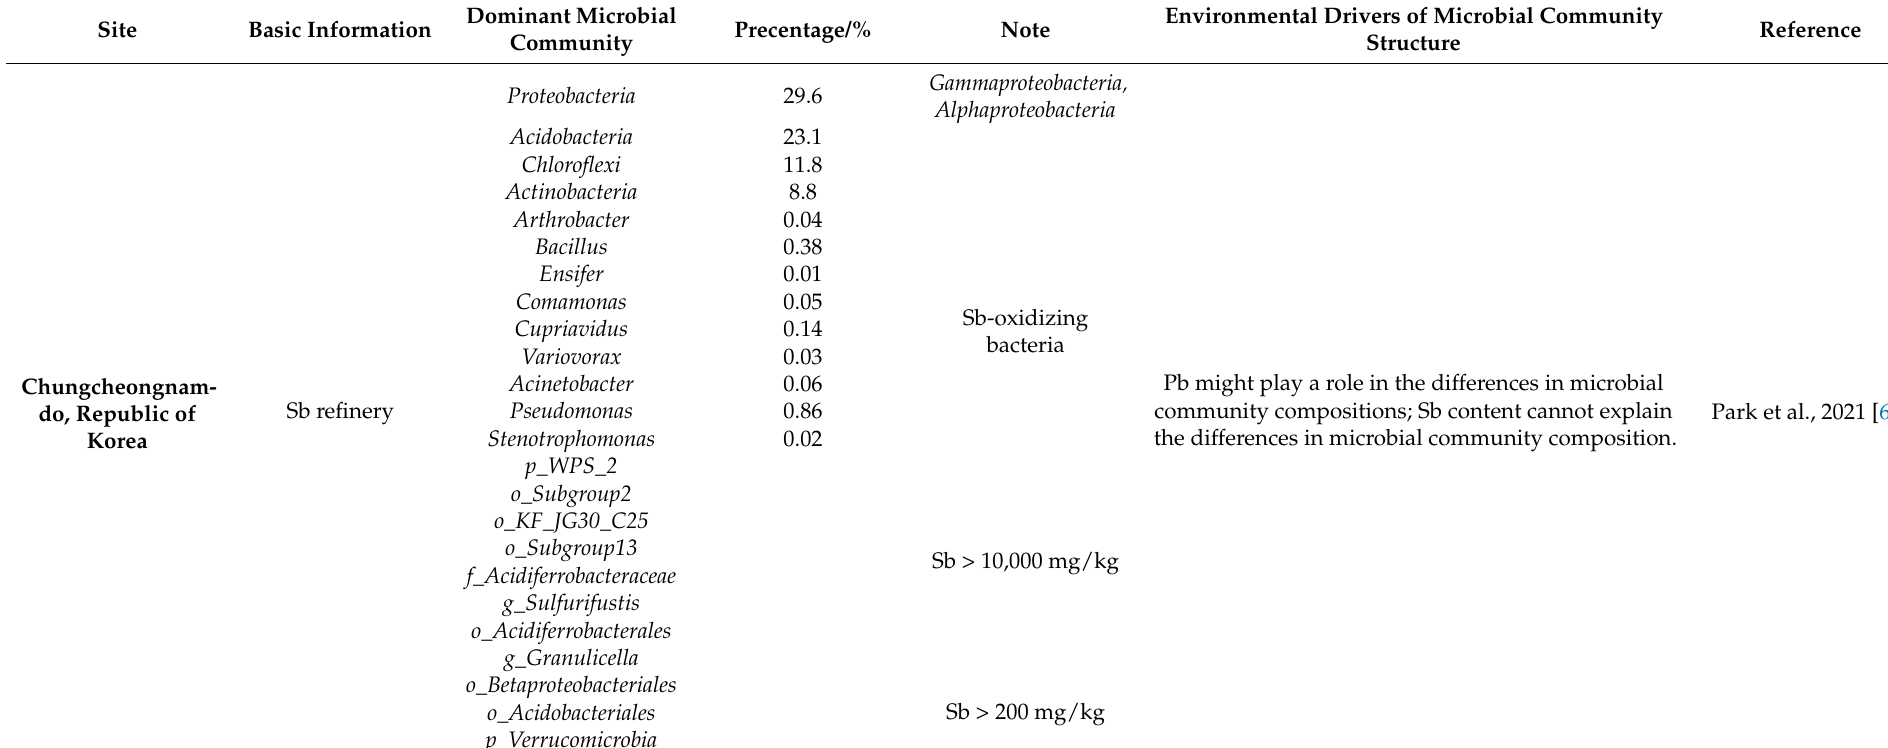
Table 2. Microbial community in soils from mining-contaminated